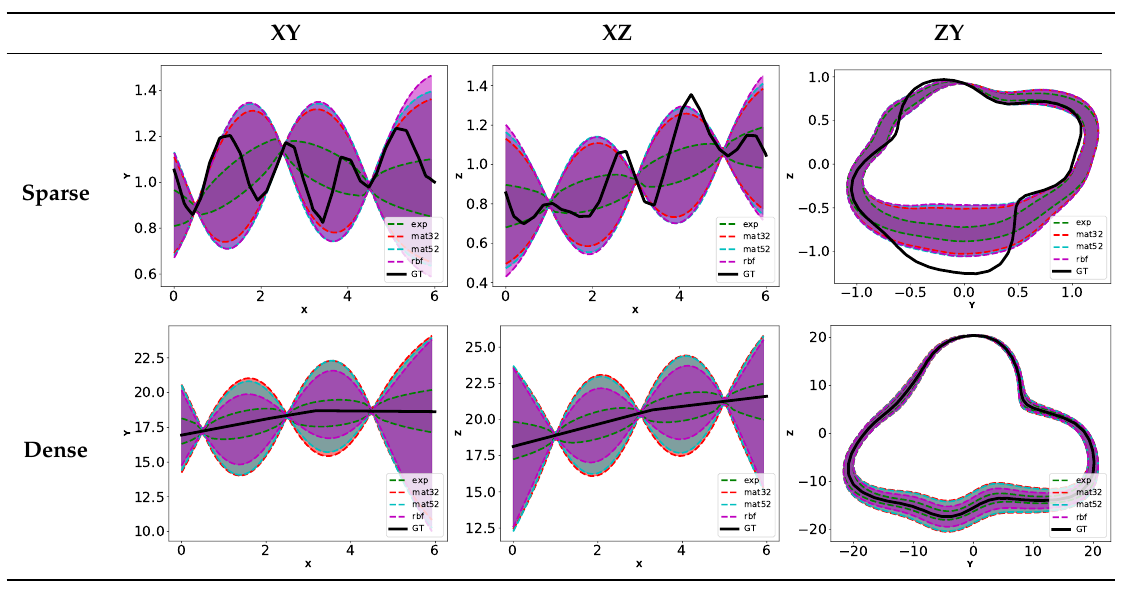
Figure 13. Contours of estimated surface with K ψ = K M lengthscale l ψ